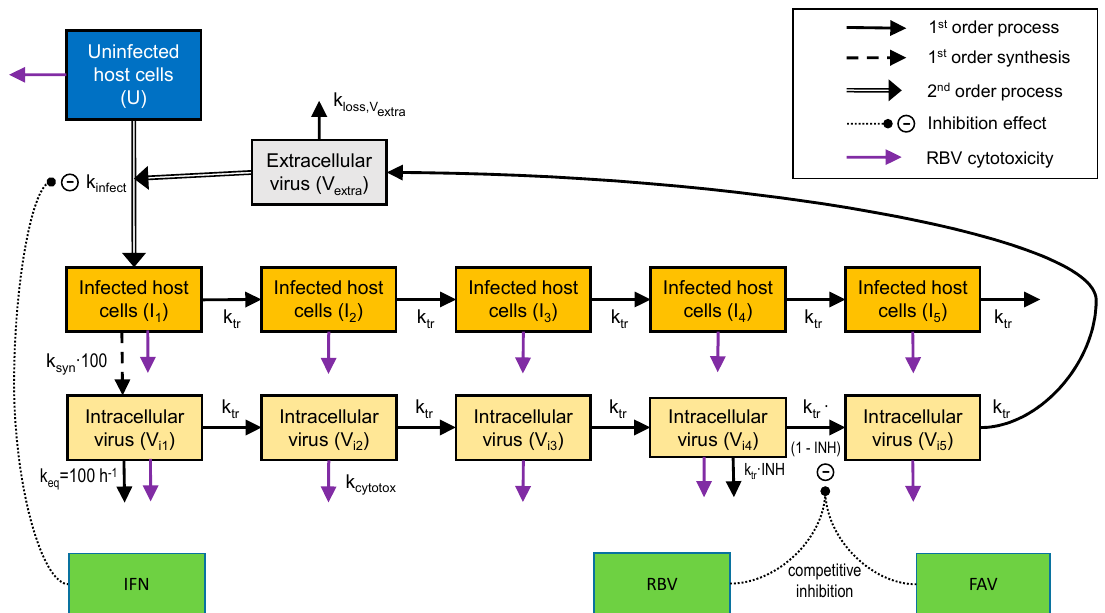
Figure 3. Structural model describing extracellular CHIKV infecting host cells, the production of intracellular virus by infected cells, as well as the inhibitory effects of FAV, IFN and RBV. The binding of extracellular virus to uninfected host cells was not affected by IFN. However, IFN inhibited the subsequent transformation from uninfected to infected host cells. Both infected host cells and intracellular virus were described by a series of five transit compartments each. In this model, virus was synthesized by the first infected host cell compartment. To achieve a rapid equilibrium between host cells in stage 1 and intracellular virus in stage 1, the first-order virus synthesis rate constant was multiplied by 100 and an equilibration rate constant (k eq = 100 h − 1 ) was incorporated for V i1 . Both FAV and RBV inhibited the transition of intracellular virus between the fourth and the fifth intracellular virus compartment via a competitive mechanism. In addition, the cytotoxicity effect of RBV was incorporated in to the model and affected both uninfected and infected host cells, and indirectly also immature intracellular virus as described in the methods. In HFF-1 cells, FAV displayed poor intracellular permeability and did not contribute any inhibitory effect. However, FAV permeability was considerably better in the other cell lines. The I (i.e., for the Ebola regimen) values for FAV, IFN, and RBV were fixed as 1